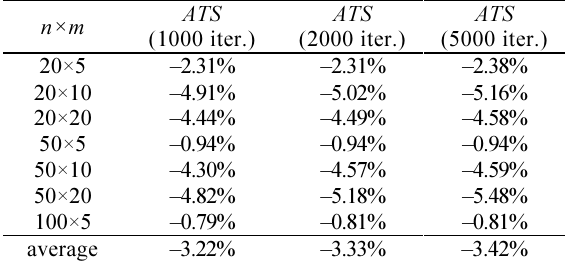
Table 2. The percentage relative deviation for the tabu search algorithm ATS as against the MNEH algorithm